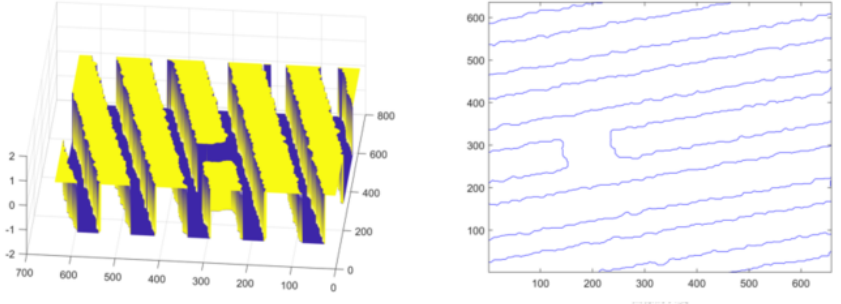
Figure 13. Evolution function and line extraction diagram after